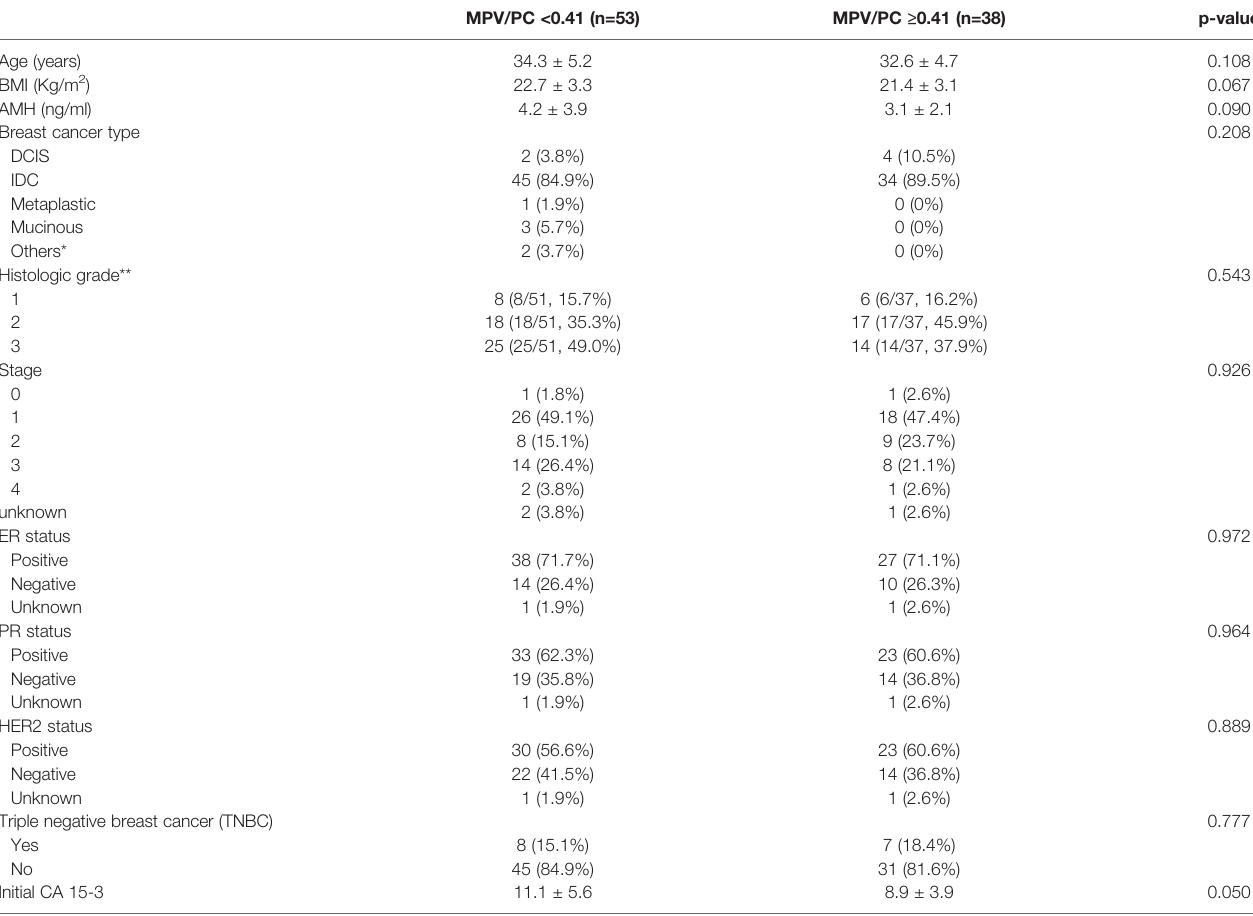
TABLE 4 | Basal characteristics of patients with breast cancer at the MPV/PC cutoff value 0.41